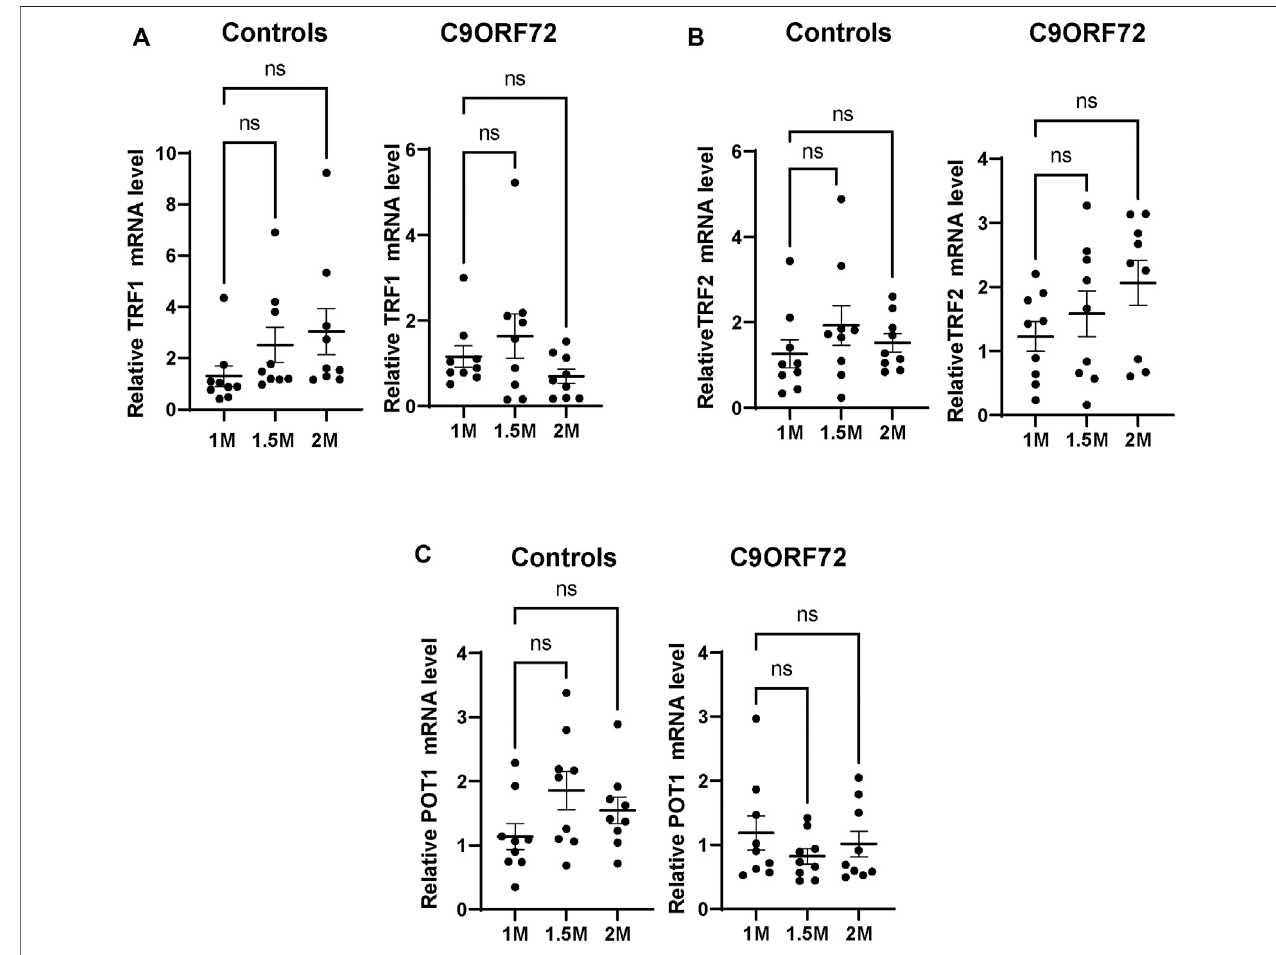
FIGURE 4 | mRNA expression of telomere maintenance genes in MNs from C9ORF72 repeat expansion carriers. qPCR analysis of the relative levels of (A) TRF1, (B) TRF2 and (C) POT1, mRNA. A one-way ANOVA was applied to compare iPSC-derived MNs at 1 month, 1.5 months, and 2 months from 3 control subjects or 3 C9ORF72 carriers from 3 independent differentiation experiments. ns, not signi fi cant.